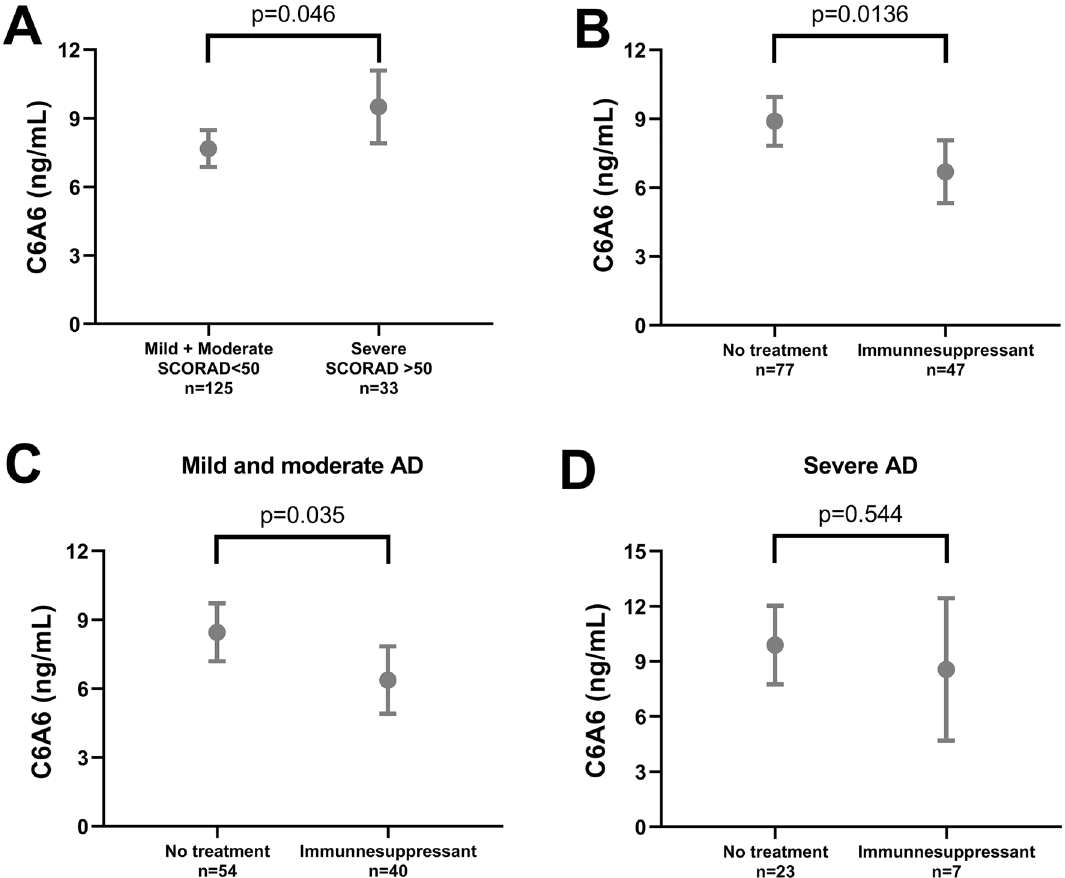
Figure 4. Levels of C6A6 stratified into disease severity and treatment. ( A ) Levels of C6A6 divided into mild and moderate AD (SCORAD; 0–50), and severe AD (SCORAD; < 50), ( B ) Levels of C6A6 divided into AD patients’ immunosuppressant treatment (topical calcineurin inhibitors), ( C ) Levels of C6A6 for mild and moderate AD patients receiving immunosuppressant treatment, ( D ) Levels of C6A6 for severe AD patients receiving immunosuppressant treatment. Mean with 95% confidence interval. Data was analyzed using an ANCOVA corrected for age. Data are depicted as mean ±